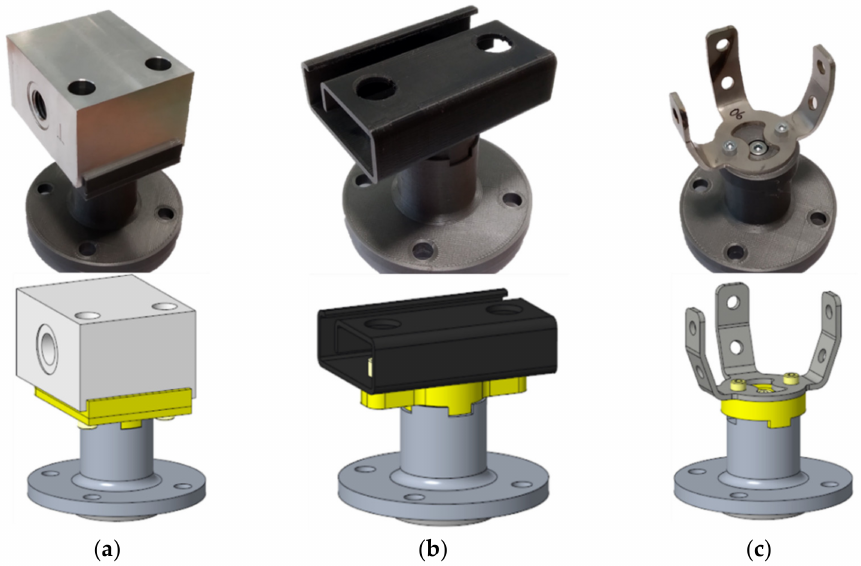
Figure 3. Objects for the experiment and their CAD models. All objects are connected to a flange that attaches to the UR10e for real measurements: ( a ) Part A and its CAD model (aluminum, roughness Ra1.6); ( b ) Part B and its CAD model (black PLA); ( c ) Part C and its CAD model